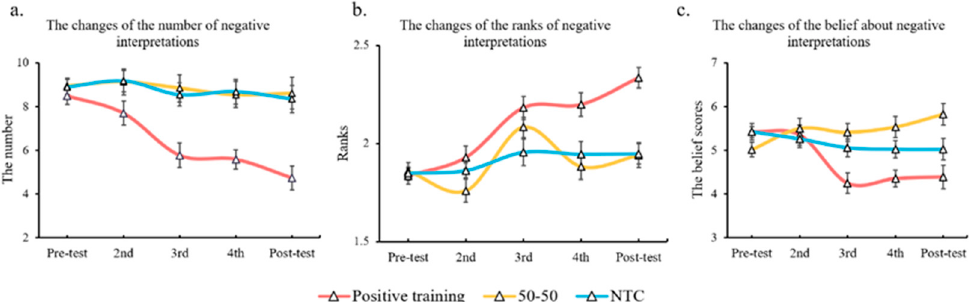
Figure 5. Changes in number ( a ), rank ( b ), and belief ( c ) about negative interpretations for three groups during the experiment.